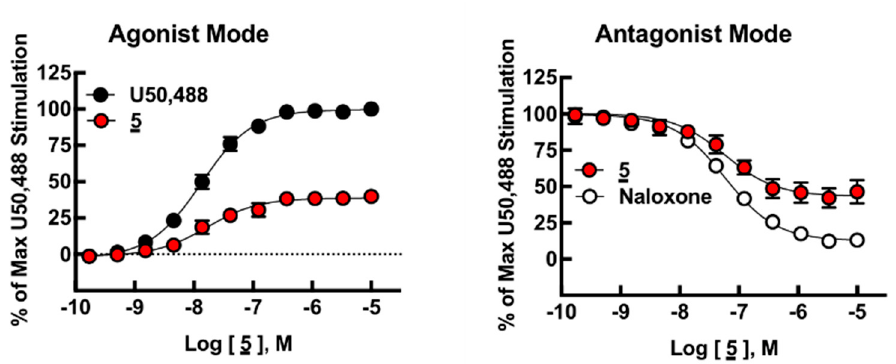
Figure 2. [ 35 S]GTP γ S assays in hKOR-CHO cells. Agonist mode dose–response curves of 5 and U50,488 ( left ). Antagonist mode dose–response curves of 5 and naloxone ( right ). Data points represent mean ± SEM of the percent of U50,488 stimulation. From n = 3 independent experiments for both modes. Three-variable non-linear regression curves fit by GraphPad Prism.